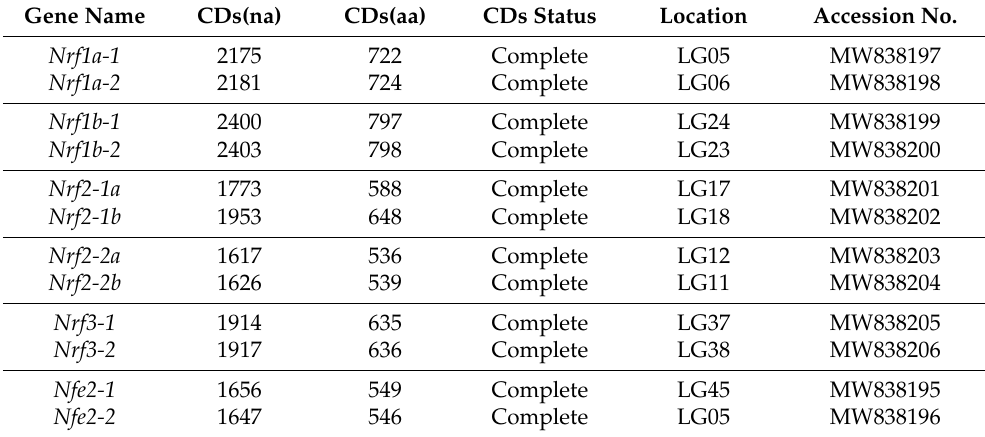
Table 2. Summary of Nrf family in common